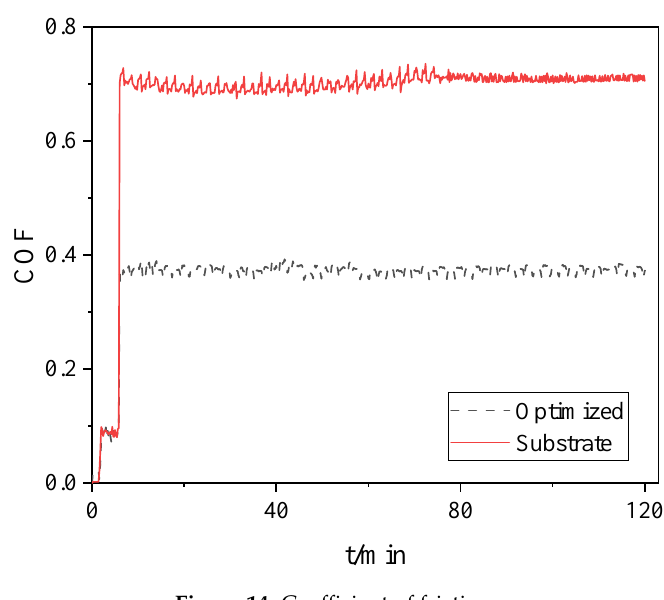
Figure 14. Coefficient of friction. Table 16. Friction and wear test parameters.